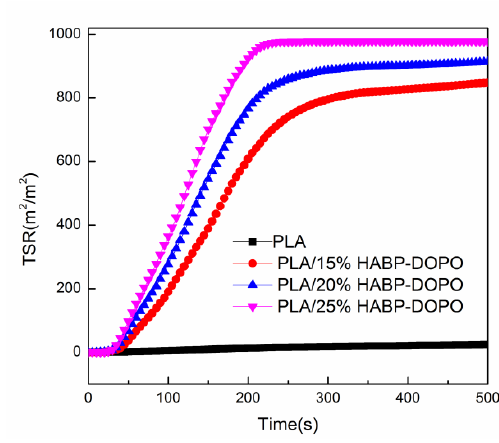
Figure 6. Total smoke release (TSR) curves of PLA and PLA / HABP-DOPO blends.